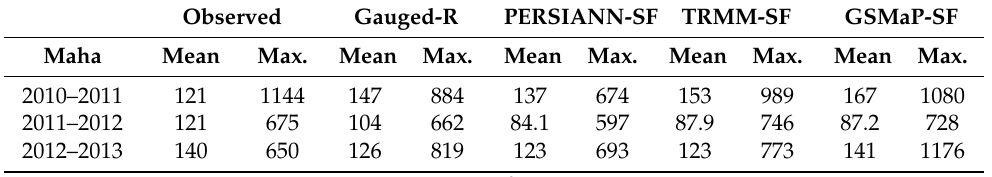
Table 4. Mean and maximum of the observed and calculated discharge in the Maha seasons.